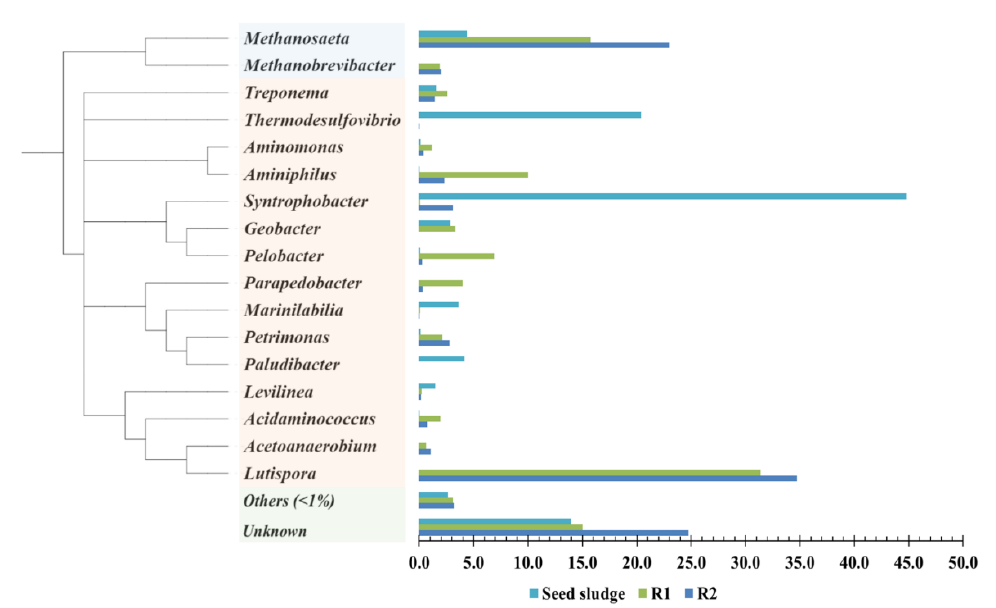
Figure 4. The relative abundances of microorganisms of seed sludge, R1 (with CHM), and R2 (with PHM) at genus level (Seed sludge: the sample was taken from the seed sludge; R1 and R2: the samples were taken at the end of operation). Genera with less than 1% abundances were classified into others.